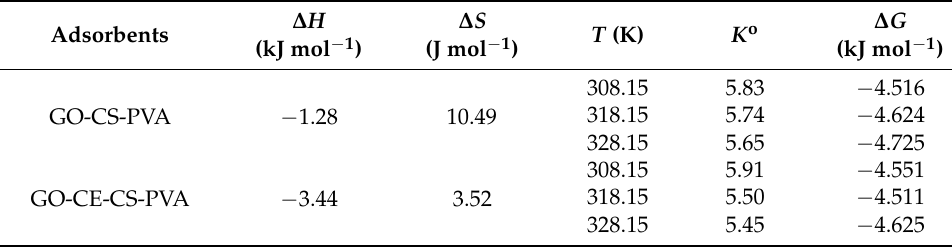
Table 3. The adsorption thermodynamic parameters of GO–CE–CS–PVA and GO–CS–PVA for Li + .